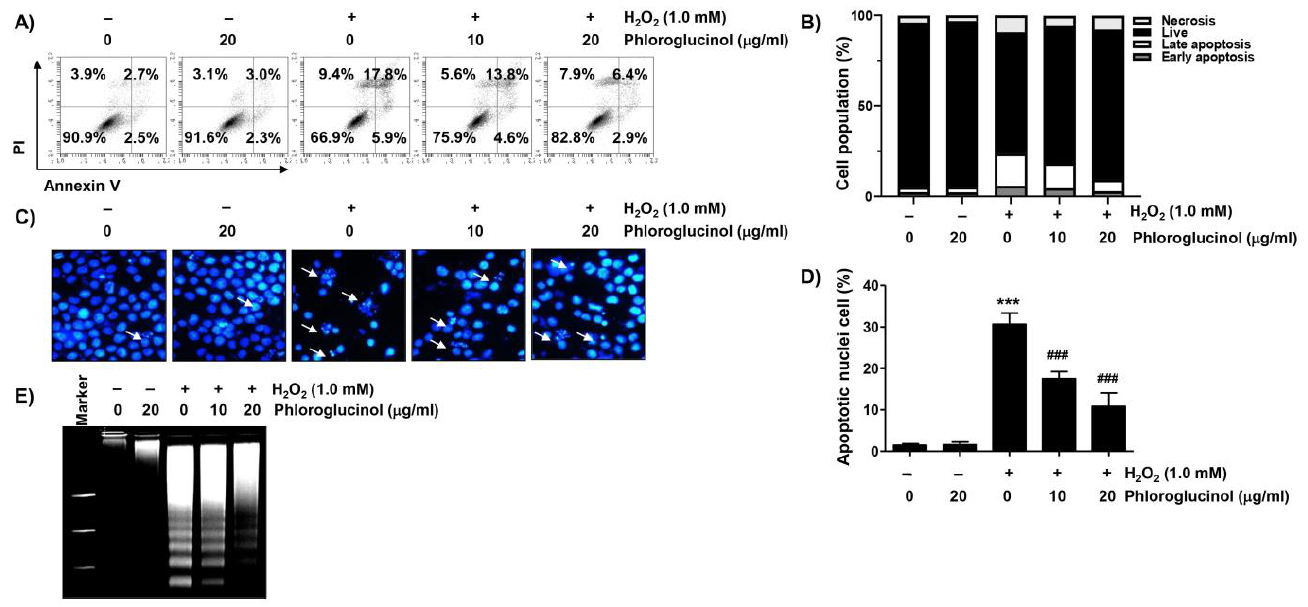
Figure 2. Phloroglucinol ameliorates cells against apoptosis in H 2 O 2 -treated C2C12 myoblasts. Cells were exposed to phloroglucinol for 1 h prior to treatment with H 2 O 2 for 24 h. Cells were exposed to vehicle for control group. ( A , B ) To measure the frequency of apoptosis, flow cytometry was performed after staining with annexin V-fluorescein isothiocyanate (FITC) and propidium iodide (PI). ( A ) Representative histograms. Cells were classified as healthy cells (lower left quadrant, annexin V − /PI − ), early apoptotic cells (lower right quadrant, annexin V + /PI − ), late apoptotic cells (upper right quadrant, annexin V + /PI + ), and necrotic cells (upper left quadrant, annexin V − /PI + ). ( B ) Quantitative results following flow cytometry are presented. ( C ) After 4,6-diamidino-2- phenolindole (DAPI) staining, images of representative nuclei are presented (400×). Arrows demonstrate apoptotic cells in different groups. ( D ) The frequency of apoptotic cells per slide was estimated by counting apoptotic cells. ( E ) Isolated genomic DNA was subjected to agarose gel electrophoresis. The DNA was visualized with ethidium bromide (EtBr) staining. Statistical difference was determined by Student’s t -test (*** p < 0.001 vs. control group; ### p < 0.001 vs. H 2 O 2 -treated cells).